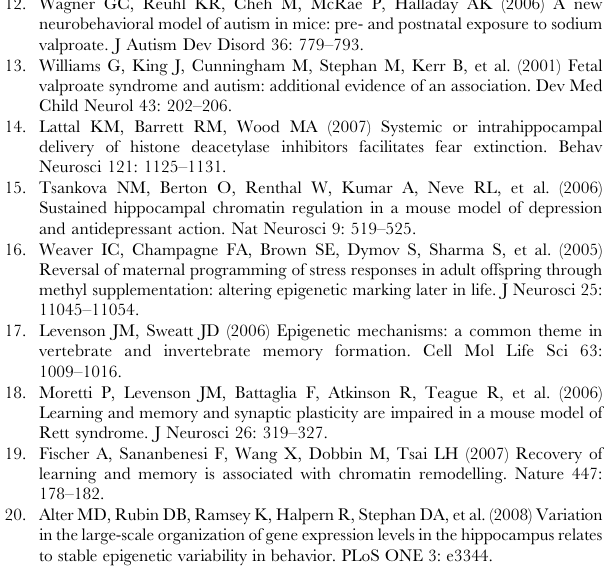
fathers2). a) Shows cross-validation of changes in gene expression variance. The means of autism1, autism2, older father1, and older father 2 are lower than the means of younger father 1 and 2, but only the autism subgroups are significantly different. b) Demon- autism1 vs. young father1 and autism2 vs. young father2 (chi- squared = 866.6, p , .00001). c) Demonstrates a significant overlap in down-regulated genes in old father1 vs. young father1 and old